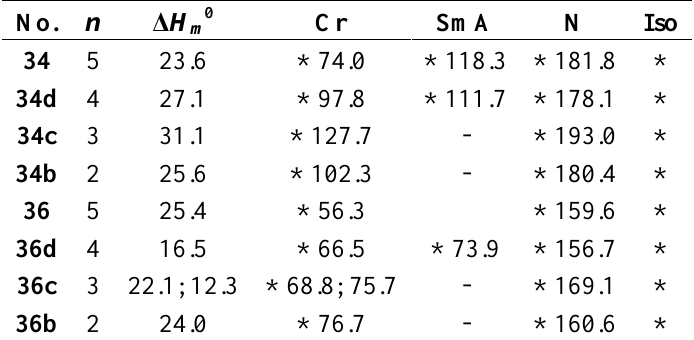
Table 7. Influence of alkyl length on phase transition temperatures [°C] and melting enthalpies [kJ/mol] in homologous series of compounds 34 and 36 [102].